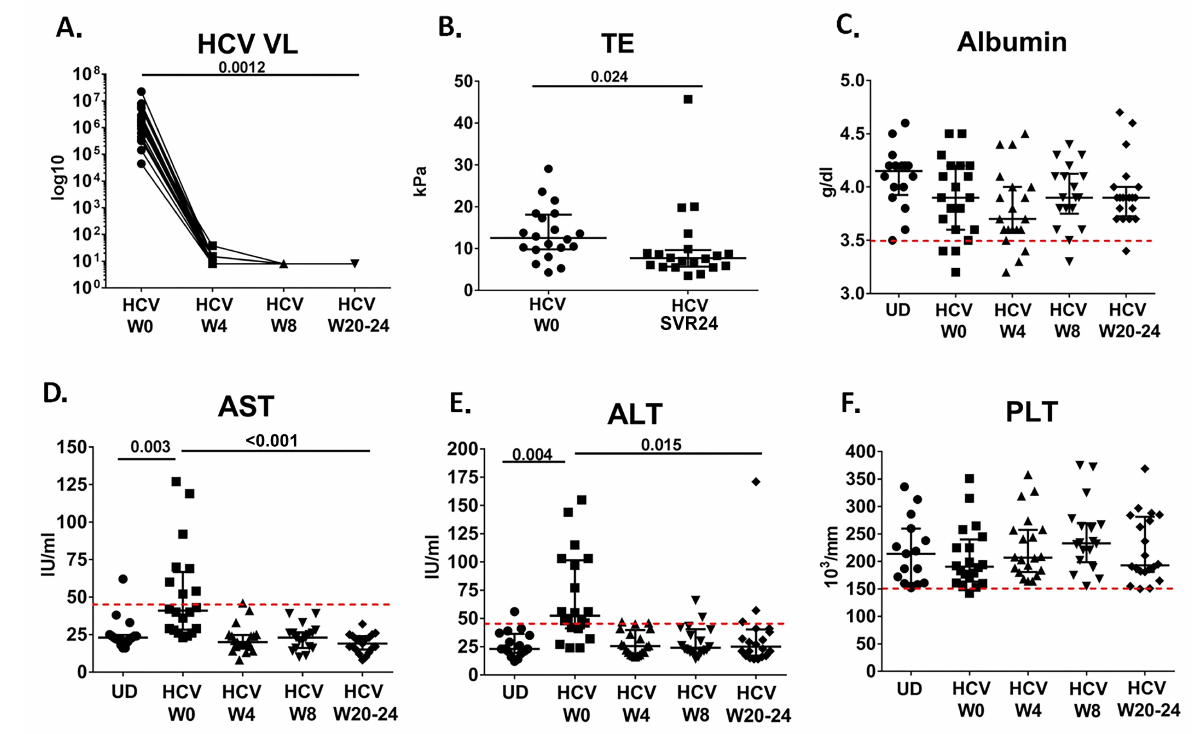
Figure 1. Normalization of clinical parameters over the course of IFN-free DAA therapy. A) Plasma HCV viral level is not detectable (lower limit of detection 15 IU/ml) at week 4 after starting DAA therapy. Log10 HCV viral level is shown over time after start of HCV DAA therapy at week 0 (w0). B) TE score (significantly decreases at week 24 after completion of DAA therapy SVR24 ( P = 0.024). C) Albumin level over course of therapy in HCV-infected cohort as well as at 1 time point in uninfected donors (UD). Red dotted line indicates lower limit of normal. D) AST level over course of therapy in HCV-infected cohort (W0, W4, W8, and W20-24) as well as at 1 time point in uninfected donors (UD). Red dotted line indi- cates upper limit of normal. E) ALT level over course of therapy in HCV-infected cohort as well as at 1 time point in uninfected donors (UD). Red dotted line indicates upper limit of normal. F) PLT level over course of therapy in HCV-infected cohort as well as at 1 time point in uninfected donors. Red dotted line indicates lower limit of